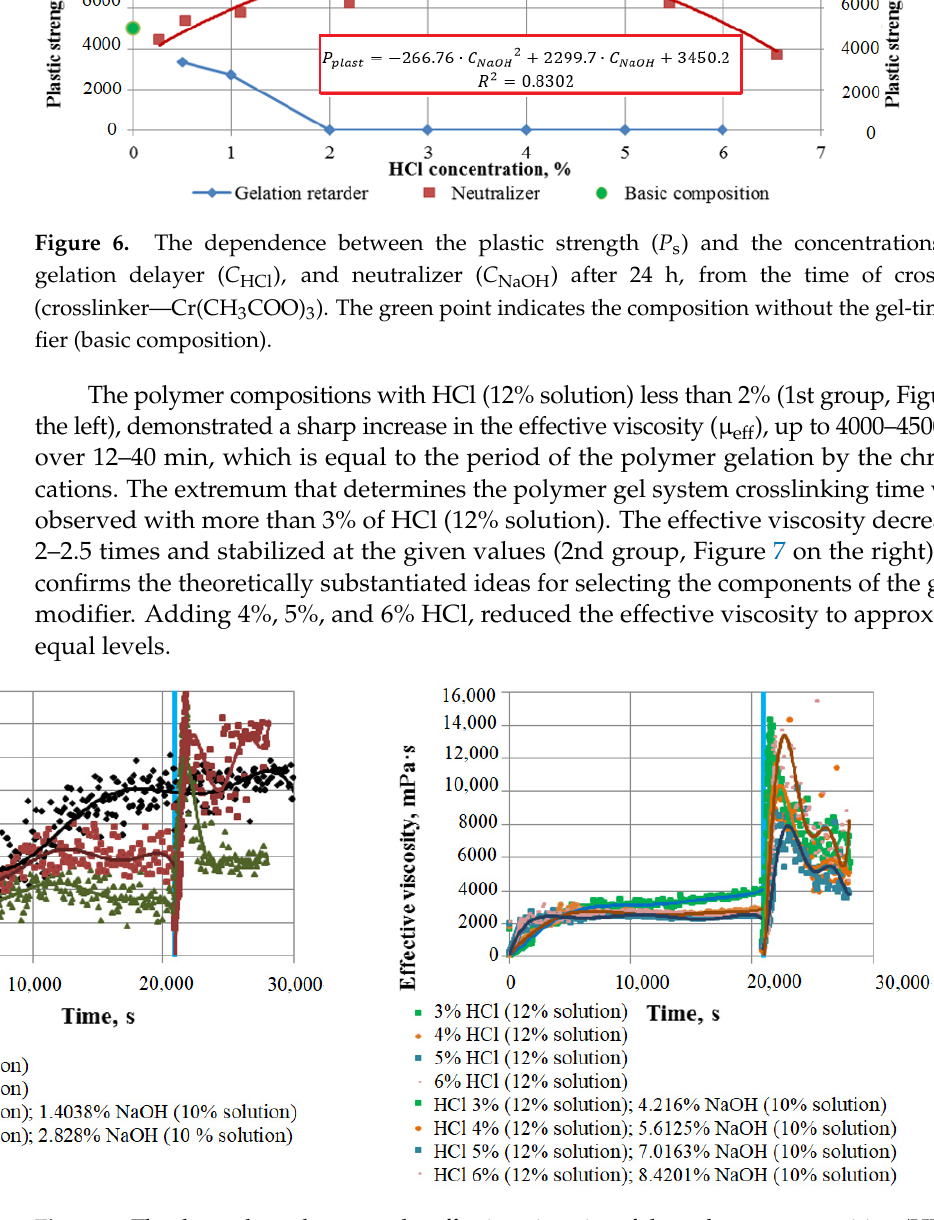
Table 4. The effective viscosity of the initial and proposed compositions with different contents of the gel-time modifier: HCl and NaOH (12% HCl solution). Time, min.